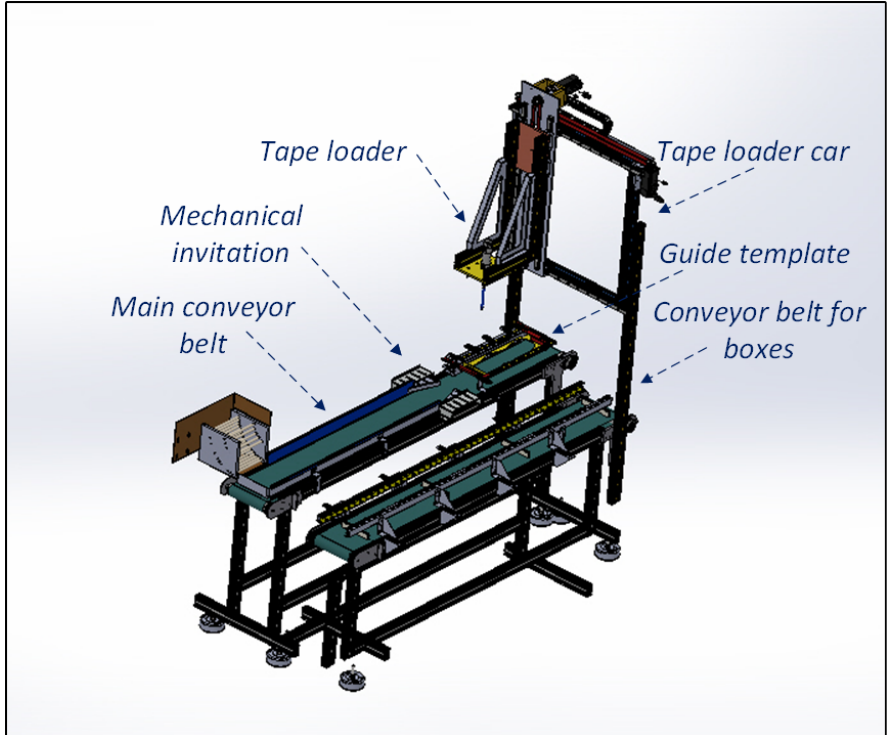
Figure 4. Representation of the packaging machine